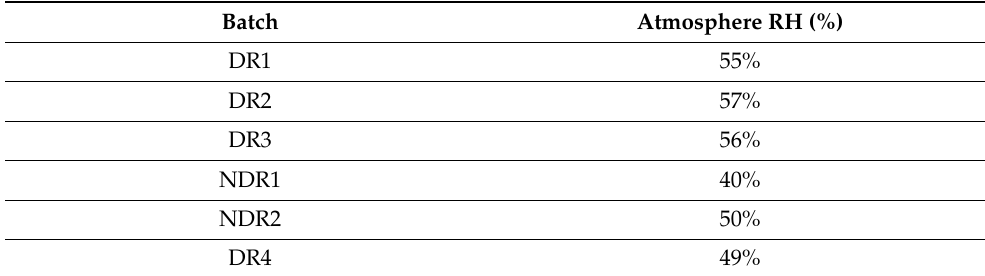
Table 9. Summary table of atmosphere relative humidity during HME